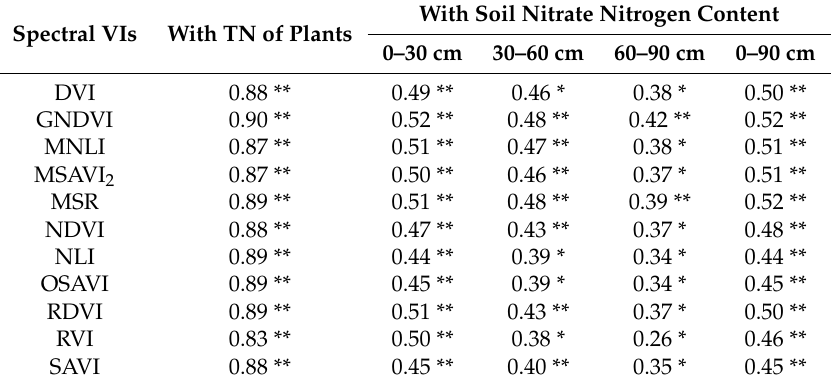
Table 5. Correlation coefficients between spectral VIs and nitrogen status of plant and soil.